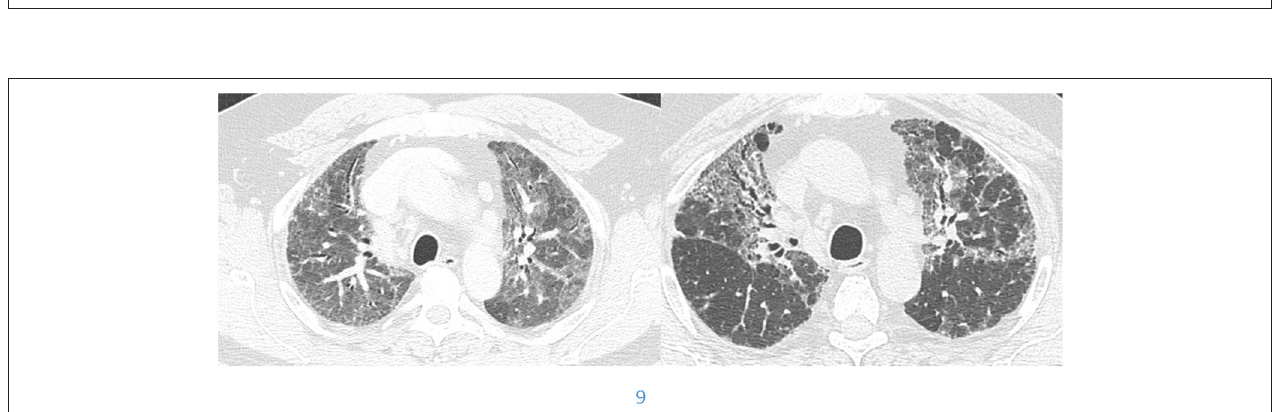
Frontiers in Medicine |